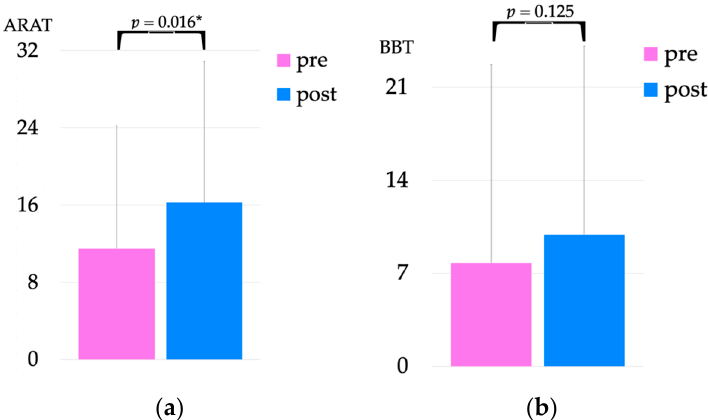
Figure 8. Comparison of ARAT ( a ) and BBT ( b ) scores pre ‐ and post ‐ intervention. * p < 0.05. ARAT, action research arm test; BBT, box and block test.